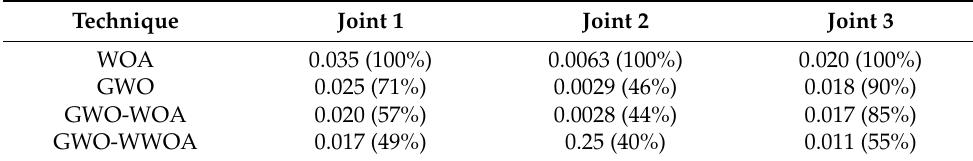
Table 3. ITAE value of WOA, GWO, GWO-WOA-WWOA technique at iteration 30.